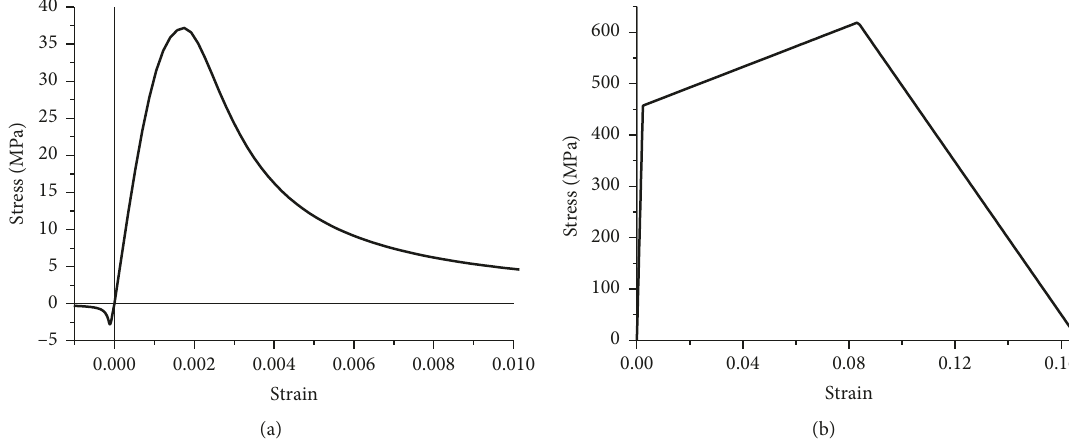
Figure 8: Uniaxial constitutive relationships of materials. (a) Concrete. (b) Rebar 12mm.